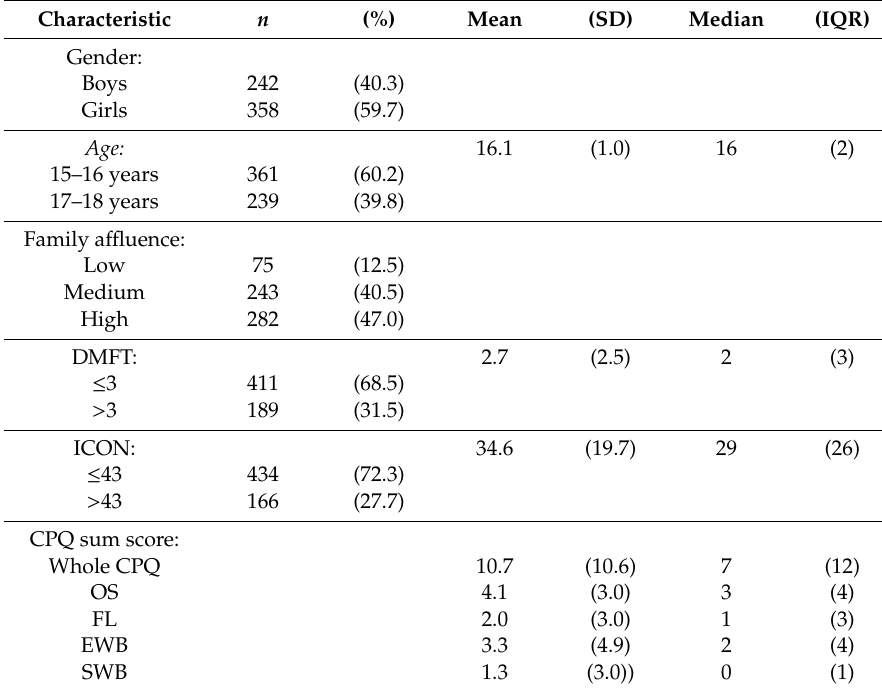
Table 1. Descriptive summary statistics of the study subjects ( N =